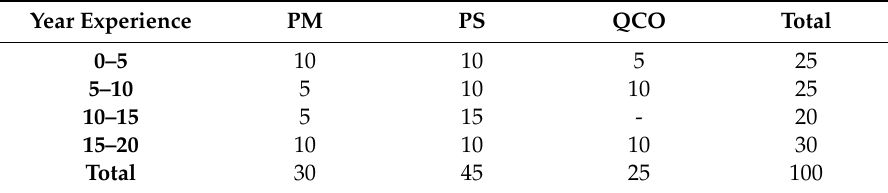
Table 3. Respondents Manufacturing